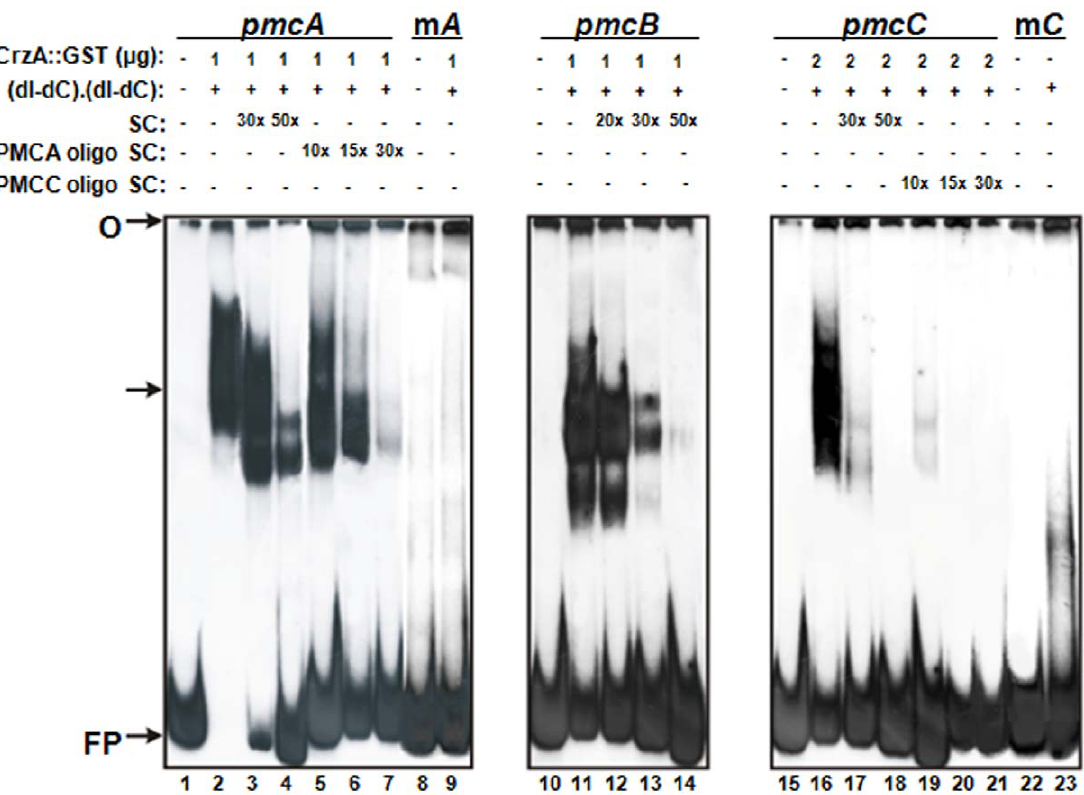
Figure 2. Binding of GST::CrzA recombinant protein to pmcA-C promoters. Gel shift analysis was performed using three DNA fragments of pmcA , pmcB and pmcC promoters as probes and 1.0 m g to 2.0 m g of the CrzA :: GST recombinant protein. Lanes 1 to 7, pmcA probe; lane 1, no protein added. Lanes 8 and 9, mutated pmcA probe. Lanes 10 to 14, pmcB probe; lane 10, no protein added. Lanes 11 to 14, fragments from pmcB probe. Lanes 15 to 23, pmcC probe; lane 15, no protein added. Lanes 22 and 23, mutated pmcC probe. O, gel origin; SC, specific competitor; FP, free probe. The arrow indicates the CrzA :: GST-DNA complexes.